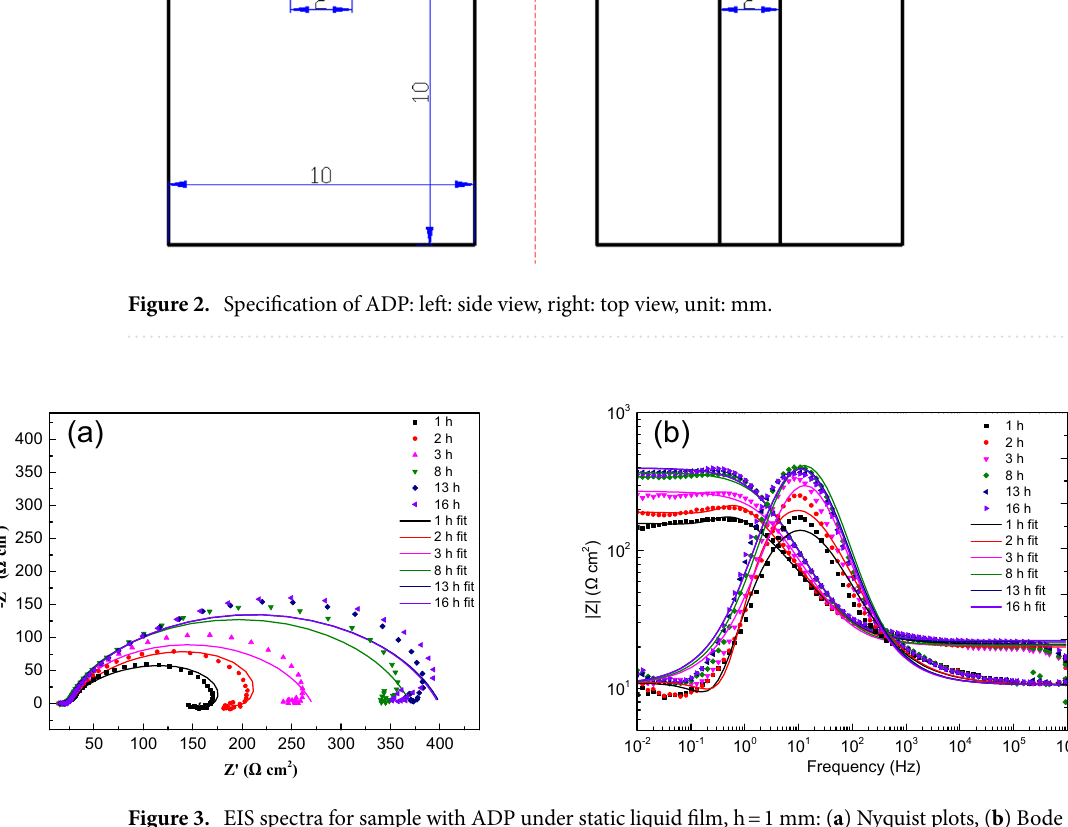
Figure 3. EIS spectra for sample with ADP under static liquid film, h = 1 mm: ( a ) Nyquist plots, ( b ) Bode and |Z|